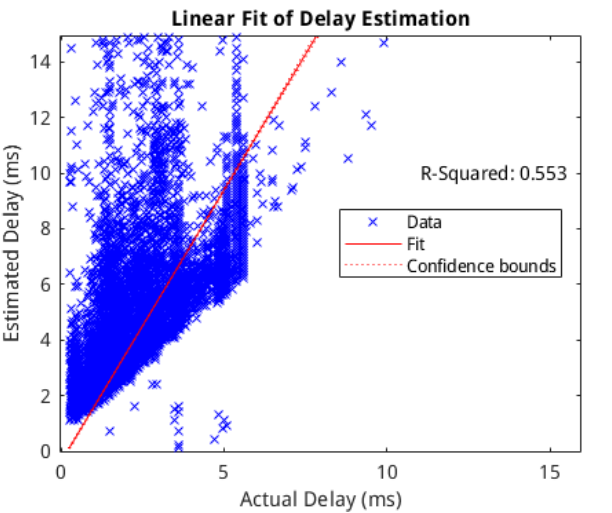
Figure 6. Correlation of delay estimate vs. actual delay with least-squares linear model and associated R-squared